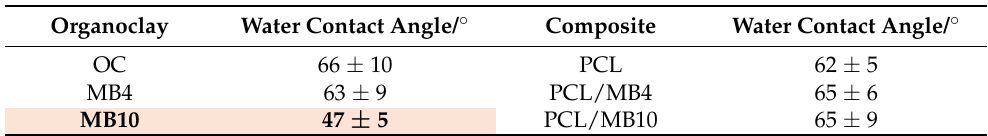
Table 1. Mean values and standard deviations of water contact angles of selected samples. The values are from over 30 repeated measurements. Organoclay Water Contact Angle/ ◦ Composite Water Contact Angle/ ◦ OC 66 ± 10 PCL 62 ± 5 MB4 63 ± 9 PCL/MB4 65 ± 6 MB10 47 ± 5 PCL/MB10 65 ±